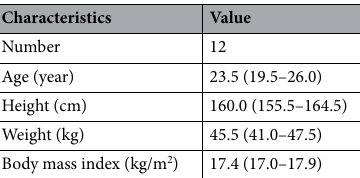
Table 1. Characteristics of female long-distance runners. Data are expressed as median (25th–75th percentile).